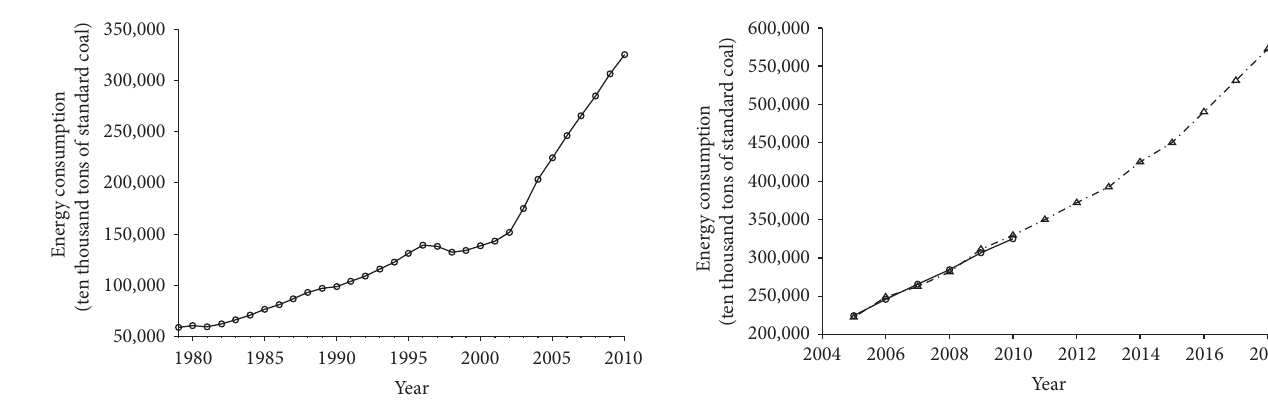
Figure 2: Annual energy consumption of China during the period of 1979 ∼ 2010.